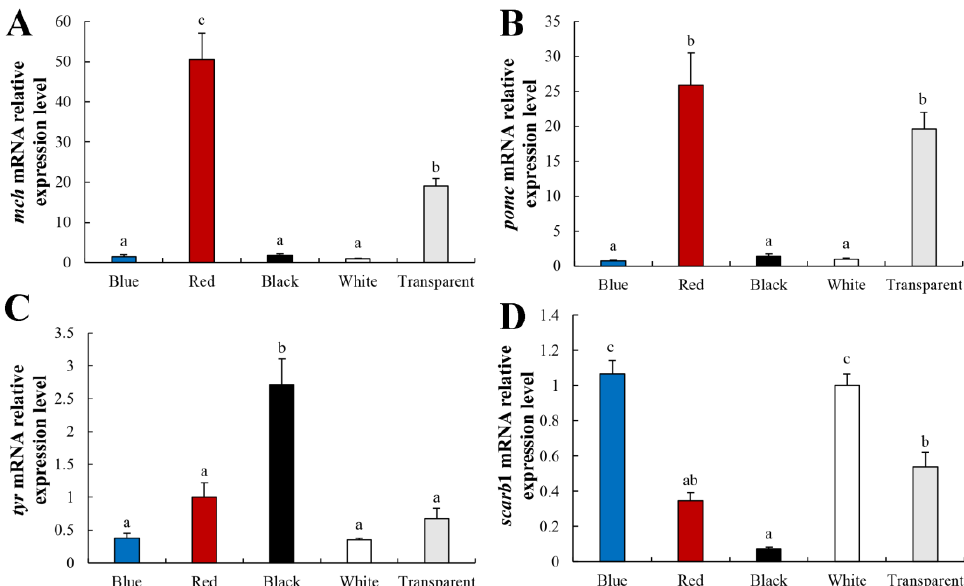
Figure 5. The expression levels of mch ( A ), pomc ( B ), tyr ( C ), and scarb 1 ( D ) in P. leopardus skin for different color. Values are means ± standard error for ten replicates. Significant differences for means within experimental groups are indicated with different lowercase letters ( p < 0.05, n = 9).